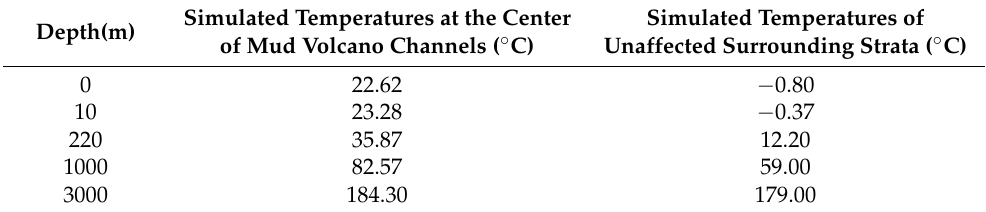
Table 4. Simulated thermometers of the central and unaffected regions of mud volcanoes at differ- ent depths.